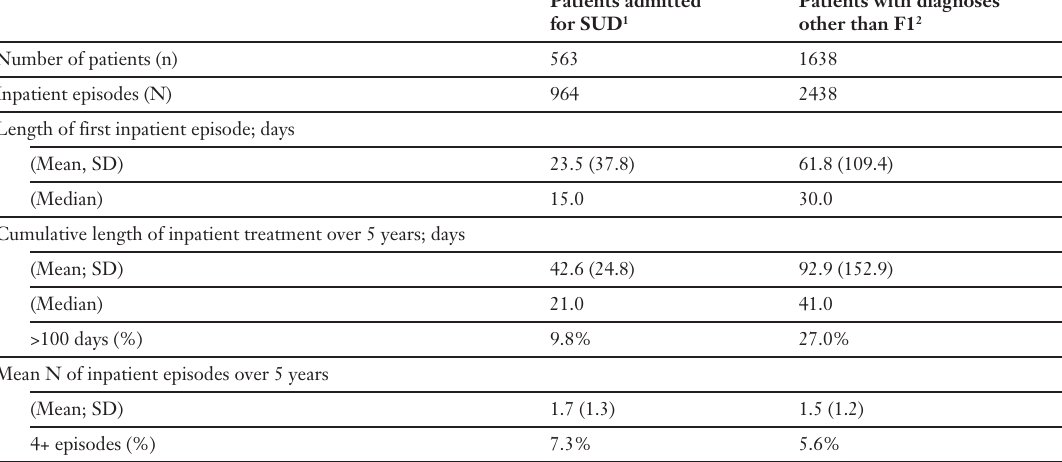
Table 1 Utilisation of in- patient psychiatric services by first- admitted patients over a period of 5